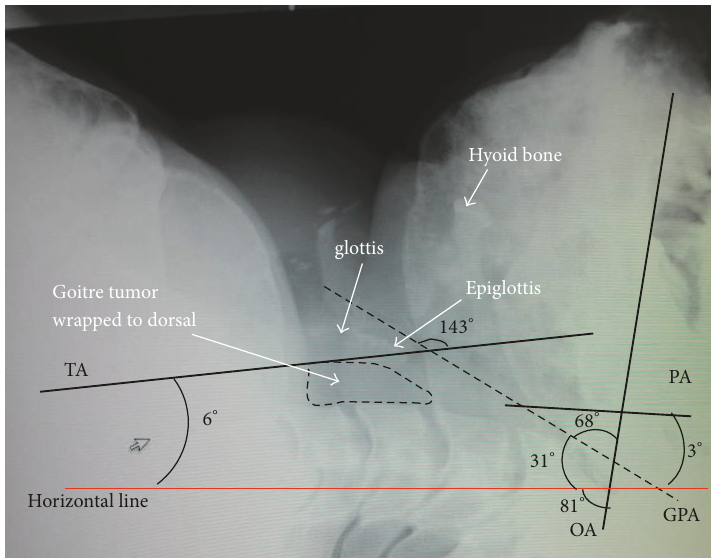
Figure2:PreoperativelateralneckX-raywiththeheadrestingonthebedinaneutralposition.X-rayshowsshortneckwithlimitedextension. The glottis is elevated by the dorsally located goitre. OA: oral axis, PA: pharyngeal axis, TA: tracheal axis, and GPA: glottis- pharyngeal axis.